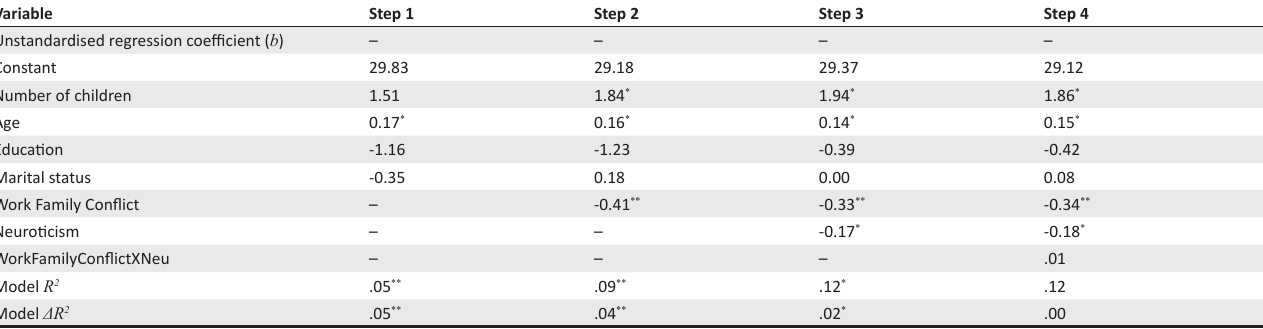
TABLE 3: Hierarchical regression analysis predicting work engagement from work-family conflict, neuroticism and WorkFamilyConflictXNeuroticism. Variable Step